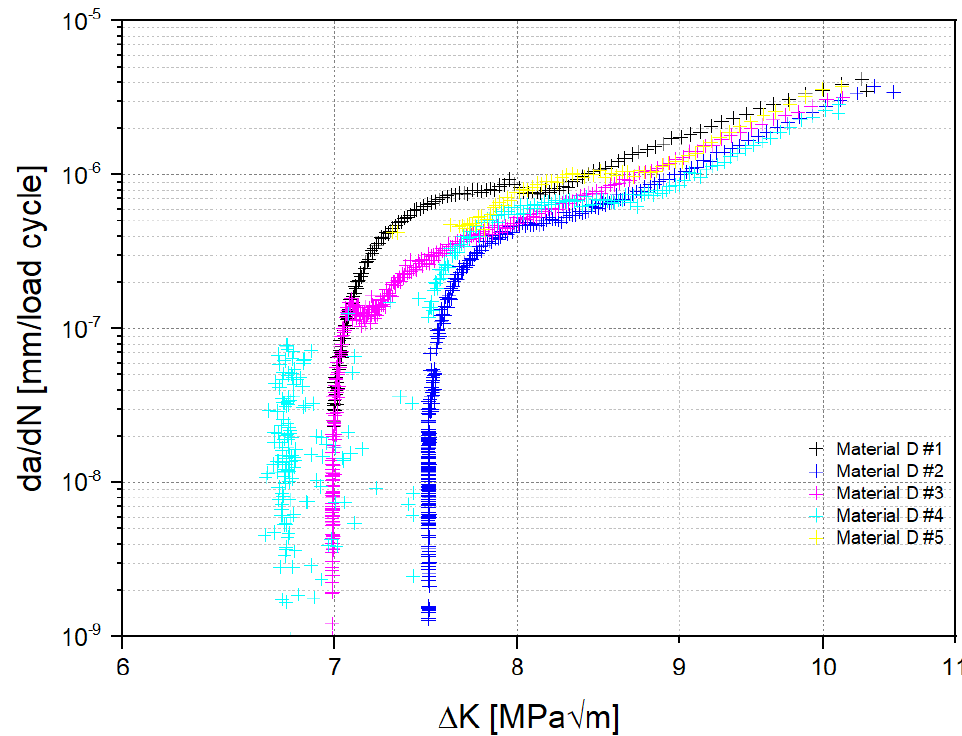
Figure 5. Fatigue crack growth curves for Material D; ECD: 7.67 mm; ALA: 21.97 mm; UTS: 1530 MPa; K IC : 107 MPa √ m—valid.